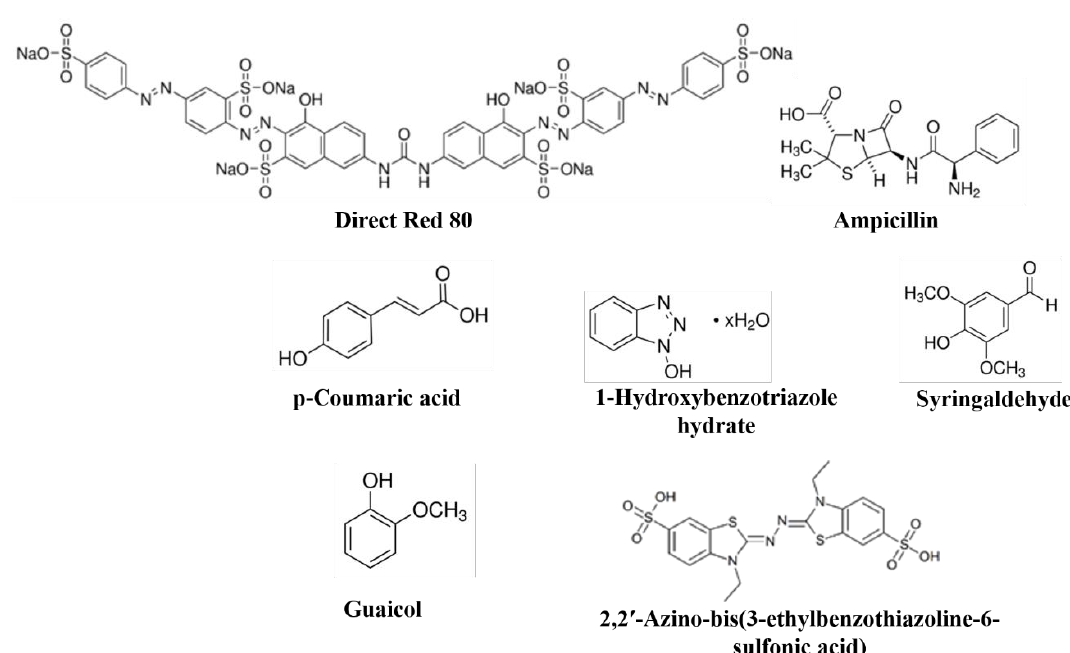
Figure 7. Structures of the environmental pollutants Direct Red 80 and ampicillin, and redox mediators, p-coumaric acid (CA), 1-1-hydroxy benzotriazole hydrate (HBT), syringaldehyde (SA), guaiacol (GUA), and 2,2′ -Azino-bis(3-ethylbenzothiazoline-6-sulfonic acid) (ABTS). The HNTs-Fe 3 O 4 -CTs-S-S-Laccase and free laccase were applied for the degradation of DR80.